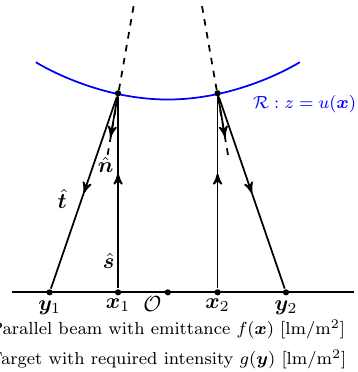
Figure 1: Schematic representation of a parallel beam of light rays, reflected by the reflector surface onto a target in the near